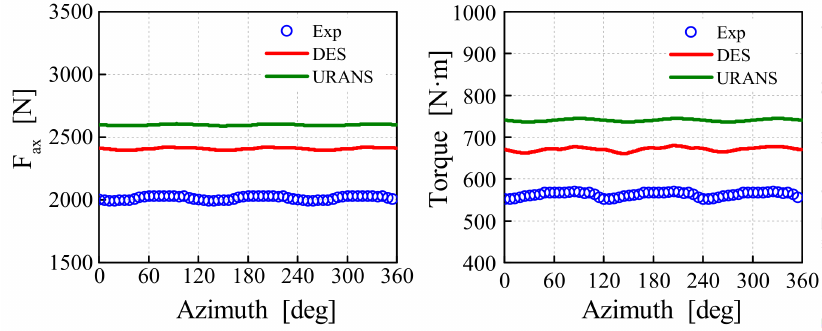
Figure 6. Comparison of the rotor axial force and torque at the wind speed of 24 m/s, TSR =